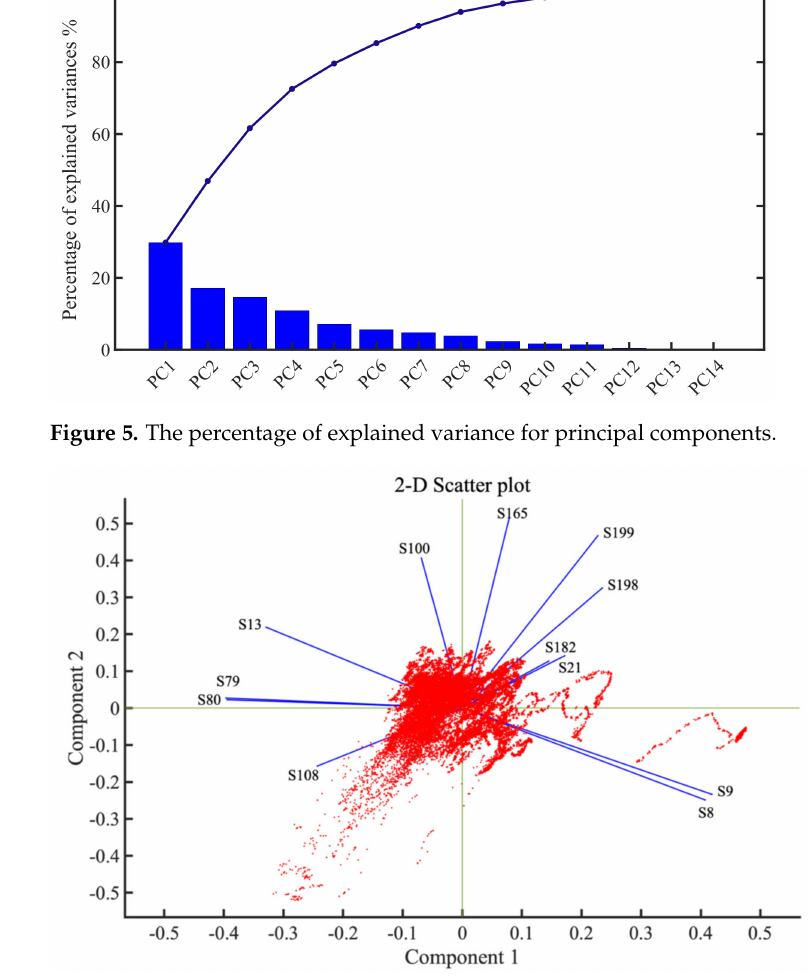
Figure 6. Scatter plot of the dataset after